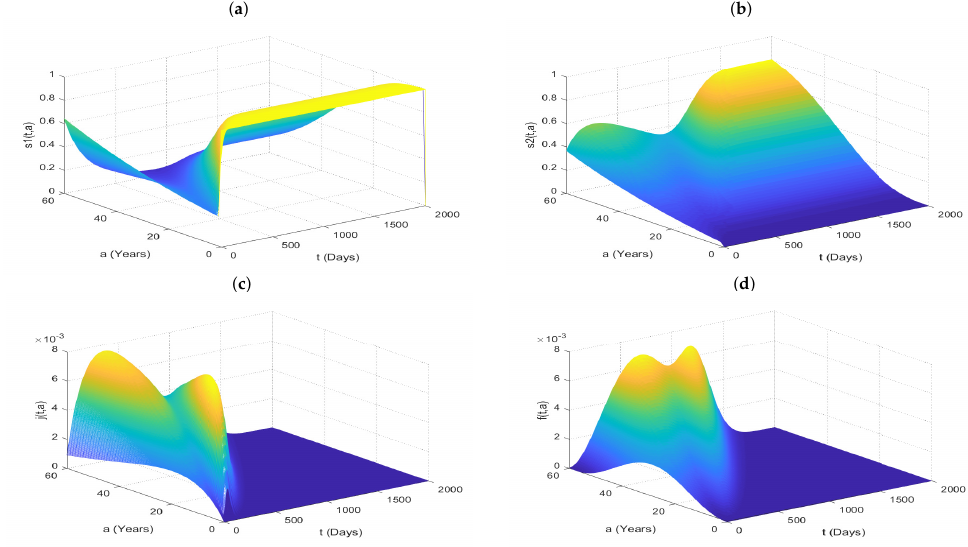
Figure 2. The distribution of solution for model (4) with the basic reproduction number R = 0.8878 < 1: ( a ) the distribution of s 0 j ( t , a ) ; ( d ) the distribution of f ( t , a ) .